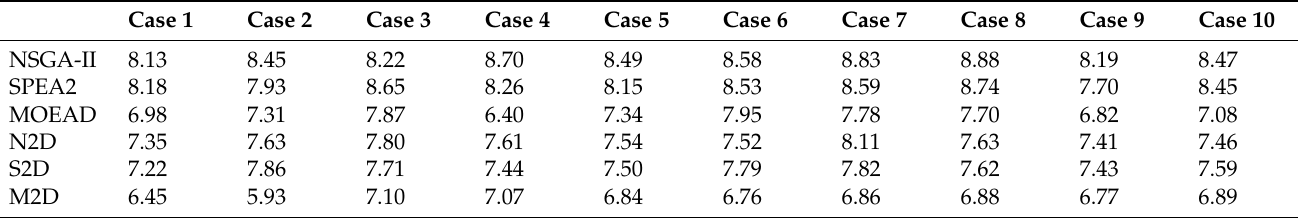
(Order of magnitude × 3